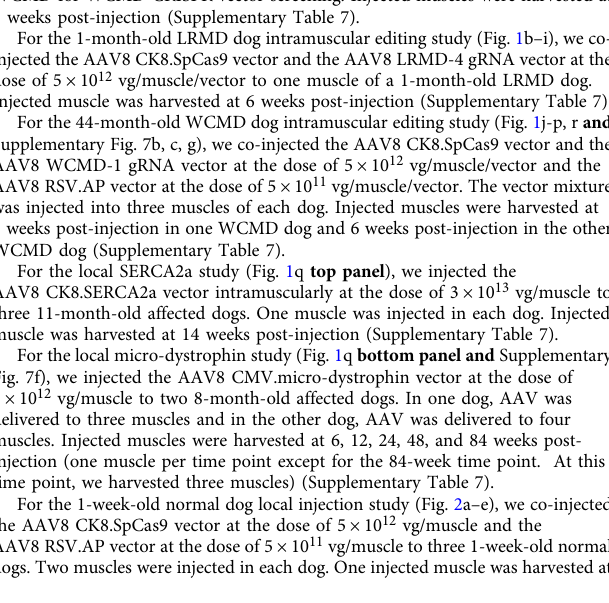
Fig. 3 Systemic AAV CRISPR therapy induced humoral and cellular immune responses against Cas9. a Representative HE, dystrophin, CD4, and CD8 stainings from biopsy. b , Representative dystrophin and CD8 stainings from necropsied muscles. c Representative HE, dystrophin, CD8, and